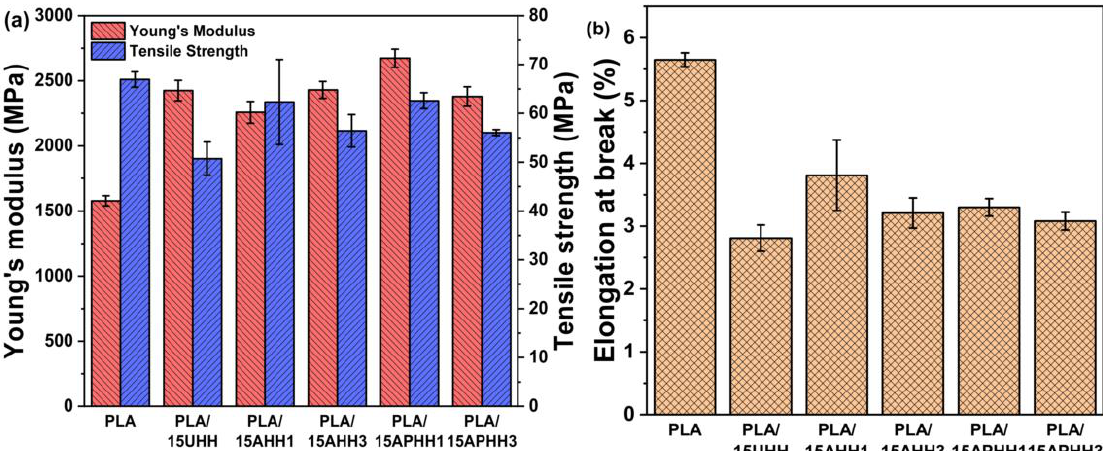
Figure 7. Mechanical properties of PLA and PLA/hemp hurd powder biocomposites with 15 wt. % filler loading. ( a ) Young’s modulus and tensile strength, ( b ) elongation at break (note: average values and standard deviation of five independent measurements are